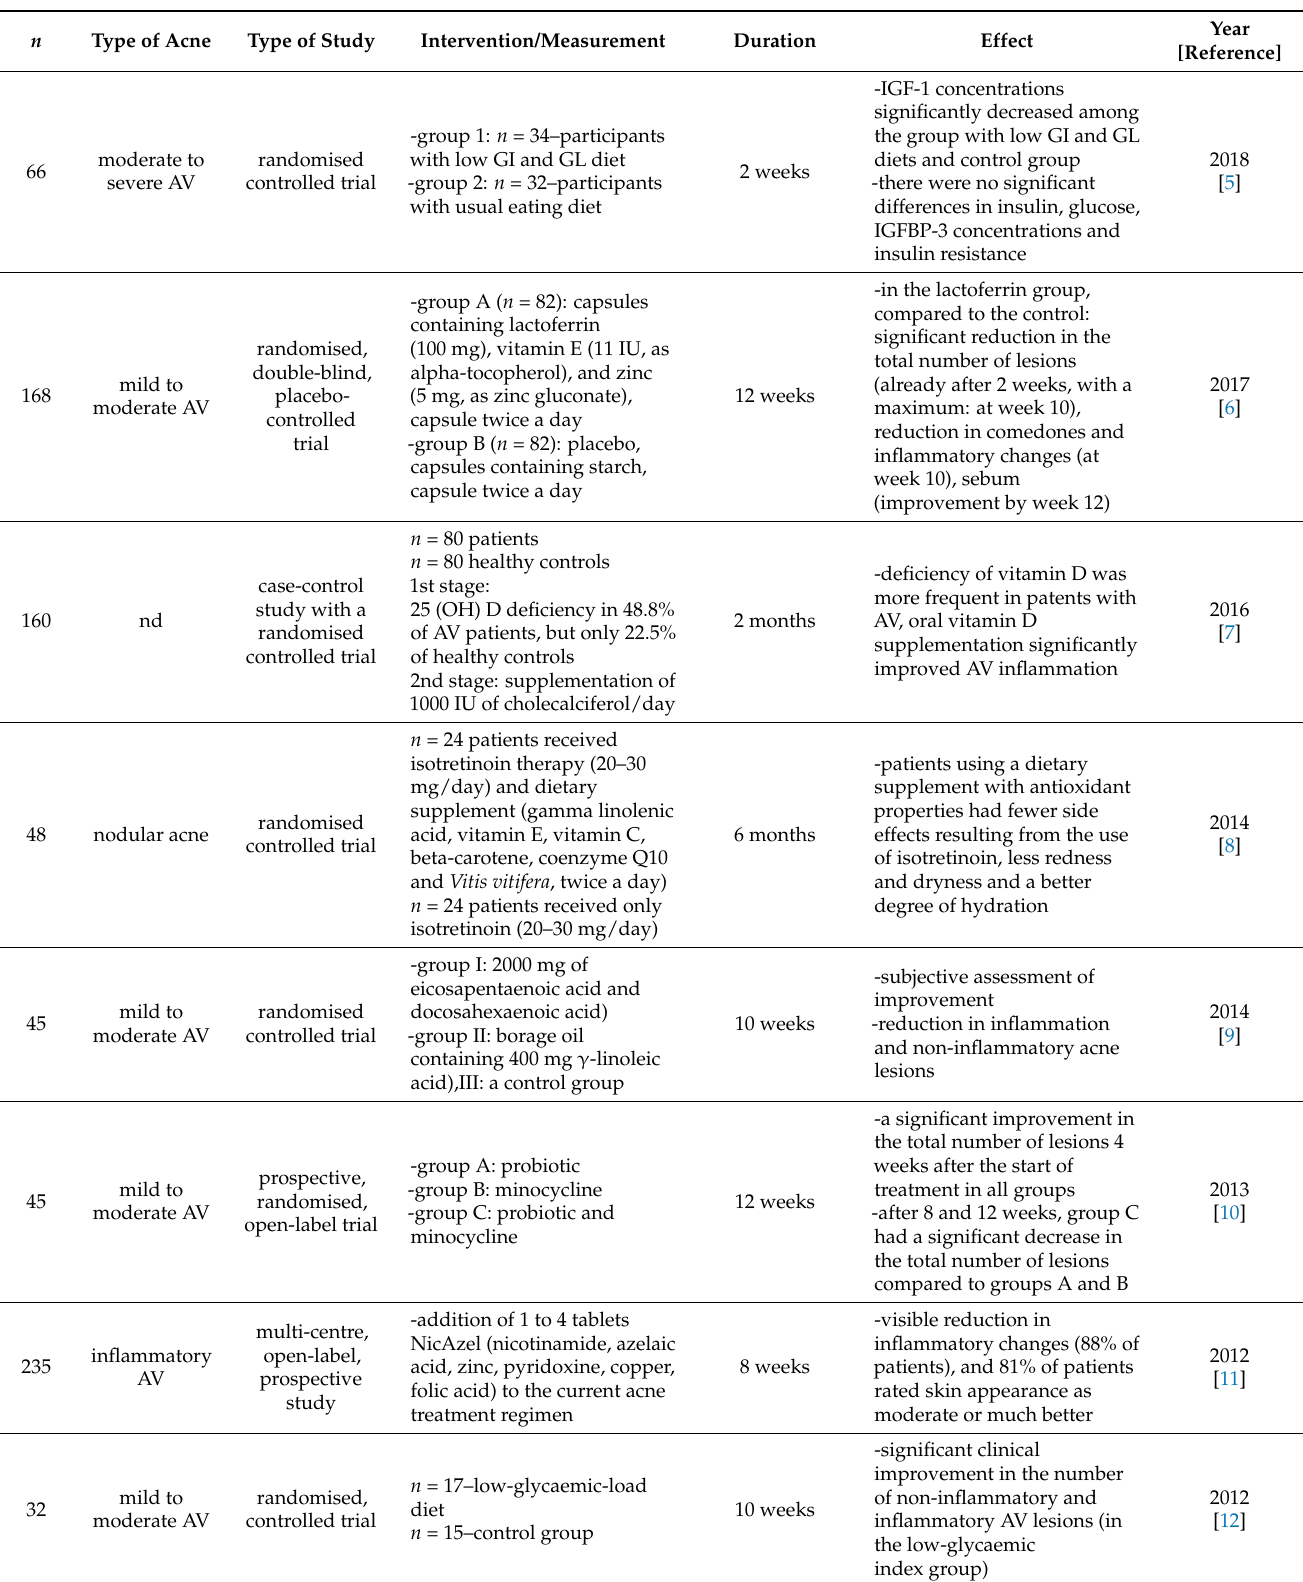
Table 1. Characteristics of studies describing acne diet